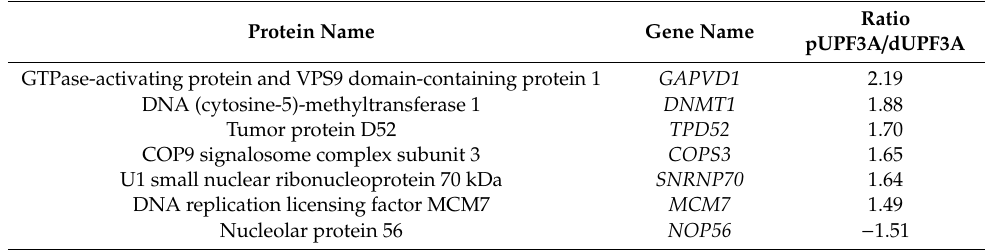
Table 4. UPF3A-induced protein regulation ( > 1.5 fold in at least two biological